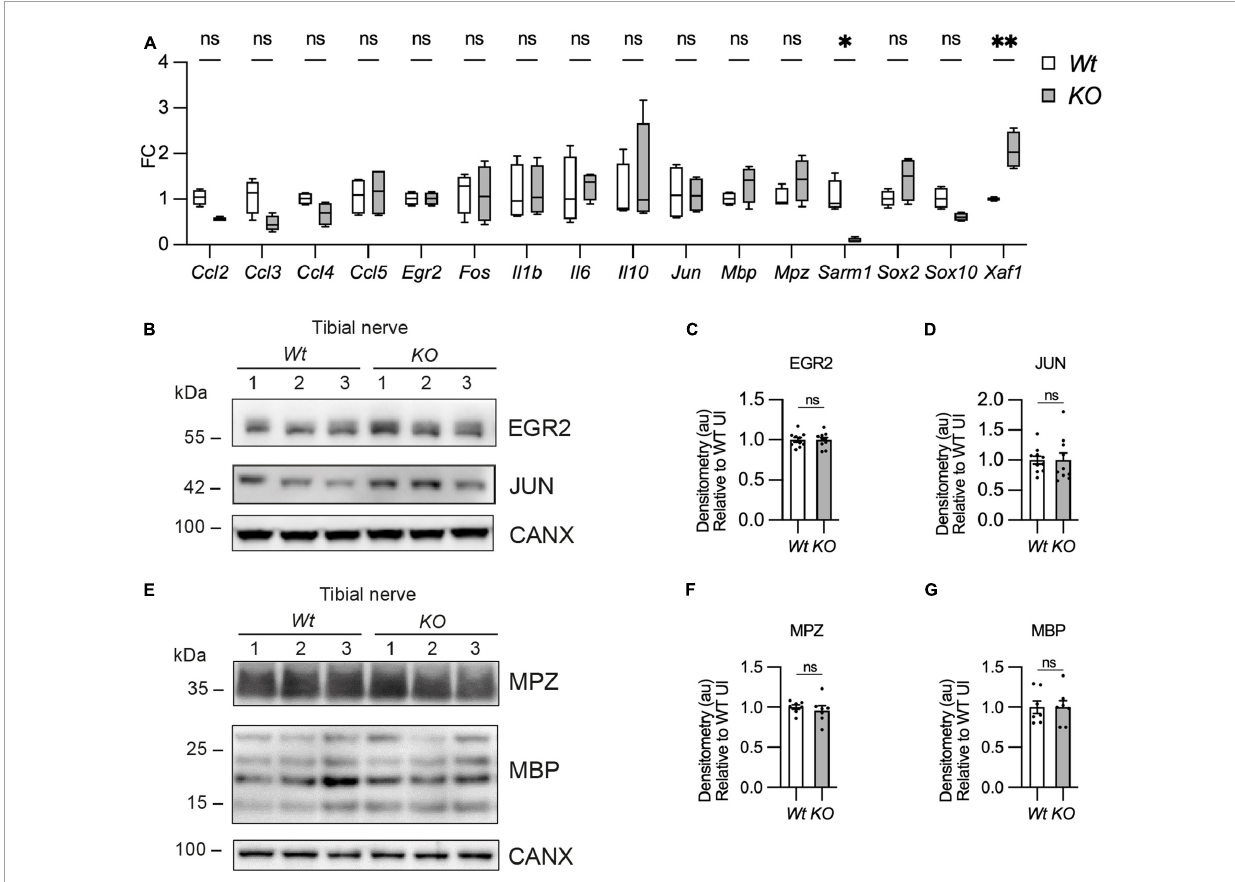
FIGURE6 Myelin gene expression is normal in Sarm1 null peripheral nerves. (A) Relative mRNA expression for chemokine, Schwann cell injury and myelin genes in the P60 uninjured tibial nerve of Wt and Sarm1 KO mice. All fold change values normalized to uninjured Wt tibial nerve ( n = 4; ∗ p < 0.05, ∗∗ p < 0.01). (B) Representative Western blot image of tibial nerve protein extracts from P60 Wt and Sarm1 KO mice. The image shows no difference in levels of EGR2 and JUN, between Wt and Sarm1 KO nerves. (C) There is no significant difference in EGR2 levels in Wt and Sarm1 KO nerves ( n = 7; p = 0.9118). EGR2 protein levels are normalized to the levels in Wt nerves, which are set as 1. (D) There is no significant difference in JUN levels in Wt and Sarm1 KO nerves ( n = 7; p = 0.5787). The quantifications are normalized to the levels in Wt nerves, which are set as 1. (E) Representative Western blot image showing no difference in levels of Myelin protein zero (MPZ) and Myelin basic protein (MBP), between P60 Wt and Sarm1 KO nerves. (F) There is no significant difference in MPZ levels in Wt and Sarm1 KO nerves ( Wt n = 6; KO n = 5; p = 0.3176). The quantifications are normalized to